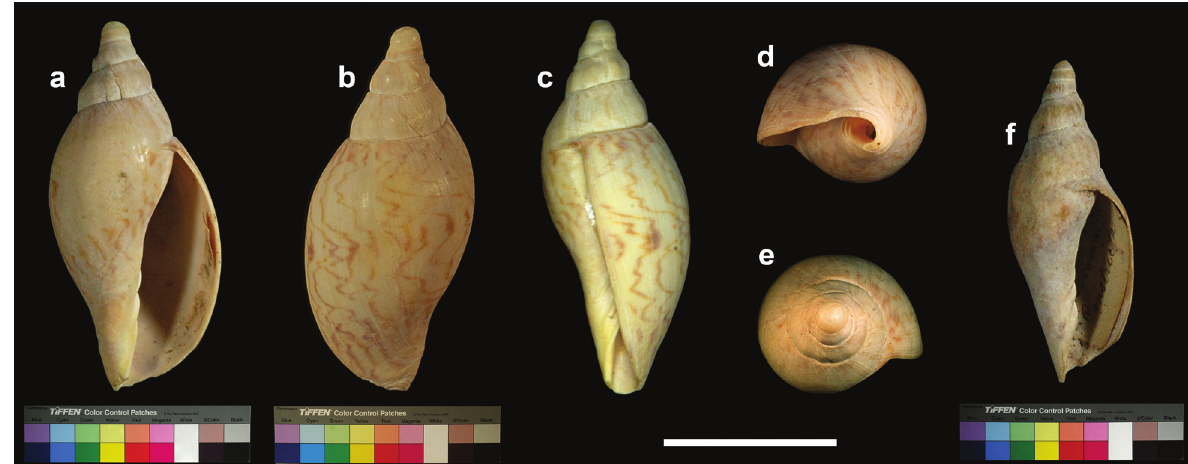
Figure 3. Voluta ambigua constricta . a–e Specimen figured by Lahille (1895: pl. VIII, fig. 164) a Apertural view b Dorsal view c Lat- eral view d Umbilical view e Apical view f Specimen figured by Lahille (1895, pl. VIII, fig. 163) in apertural view. Scale bar: 3 cm.